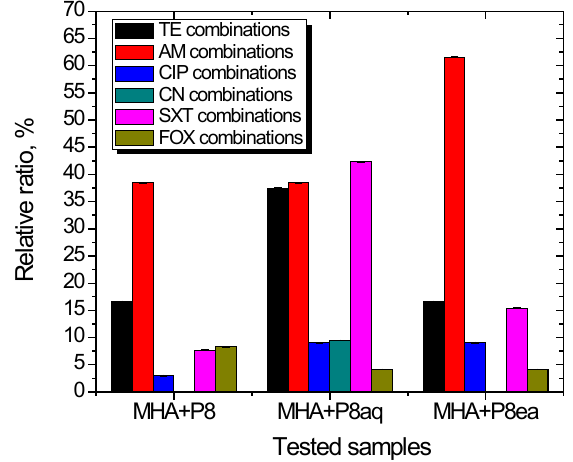
Figure 13 : E. coli ATCC 11229 response.